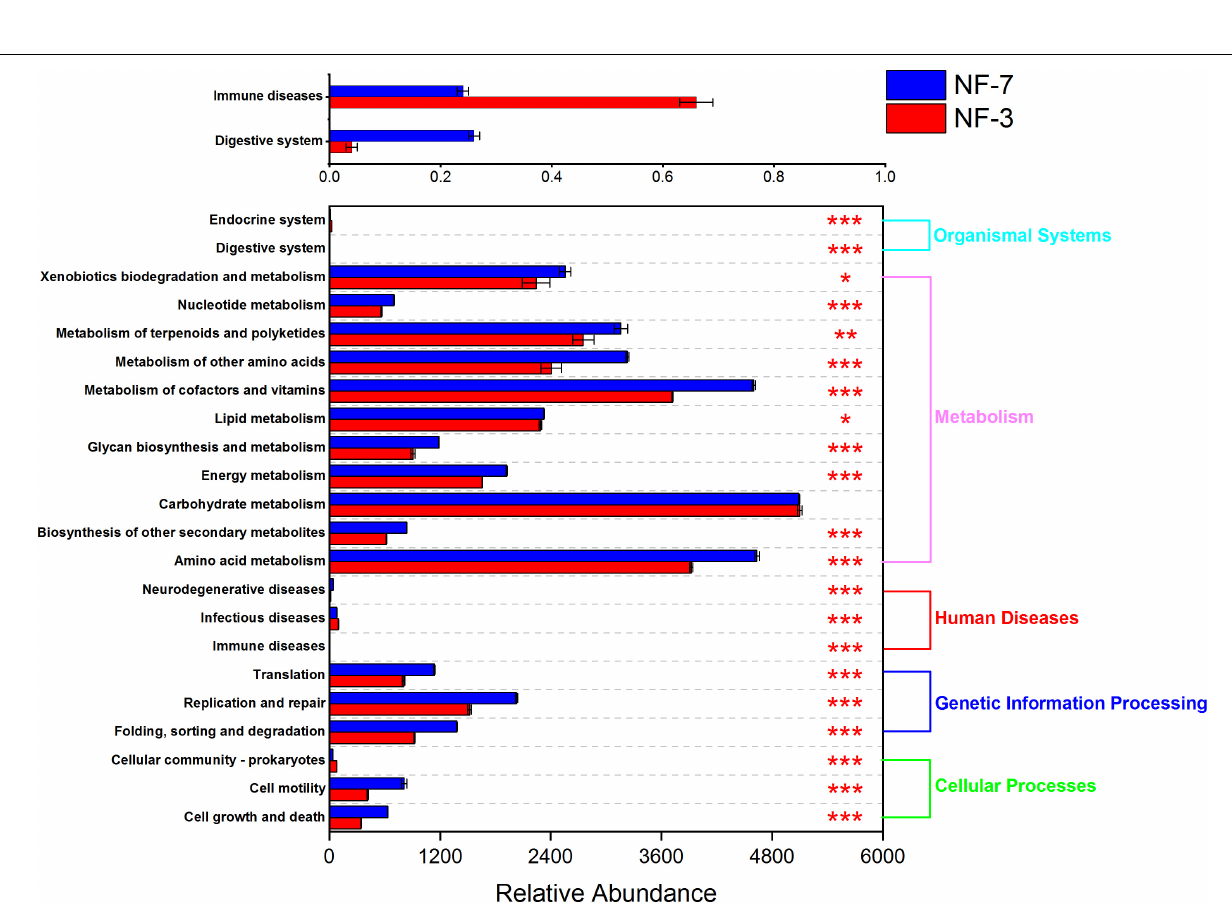
Frontiers in Microbiology |